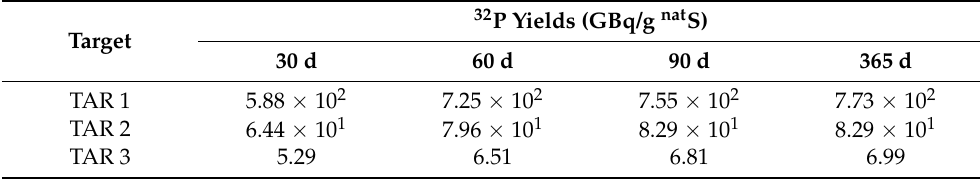
Table 4. 32 P yields of nat S at various irradiation times